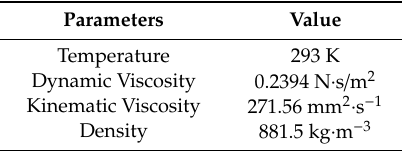
Table 3. Characteristics of the fluid in this